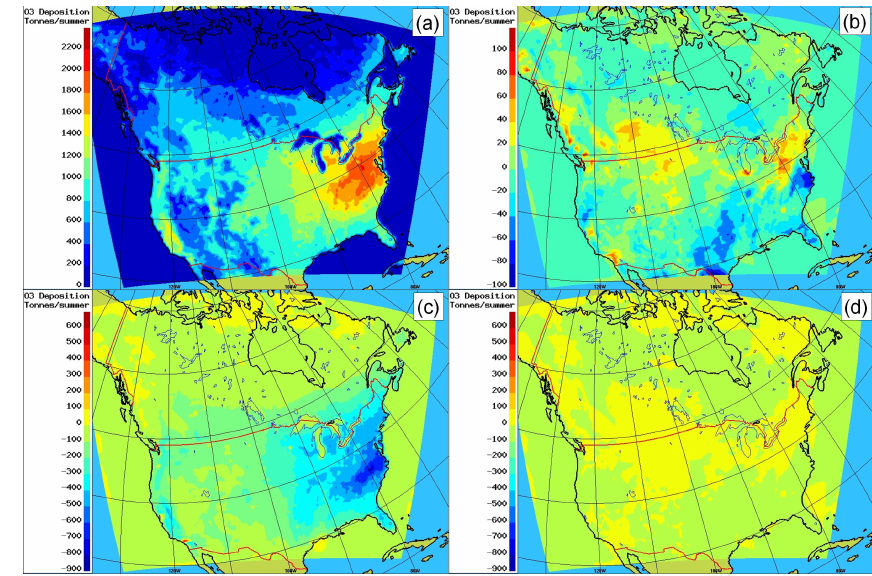
Fig. 19. Change in summer average O 3 deposition. Panels as in Fig. 6, but for O 3 deposition